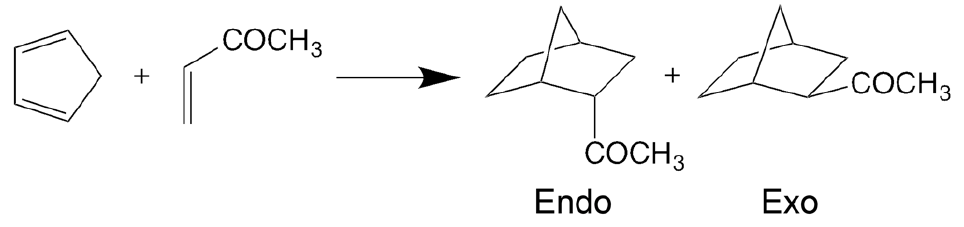
Figure 16. Scheme for the Diels–Alder reaction.